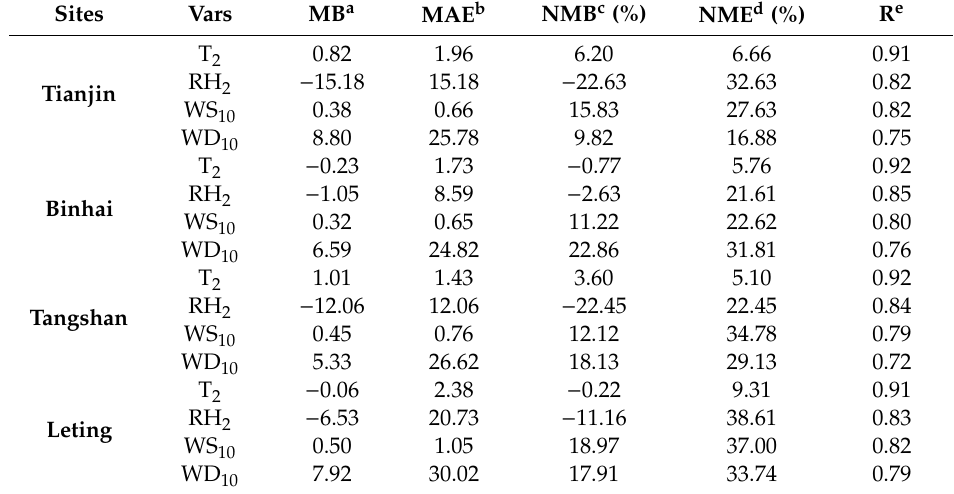
Table 3. Performance statistics for temperature at 2 m (T 2 ), relative humidity at 2 m (RH 2 ), wind speed at 10 m (WS 10 ), and wind direction at 10 m (WD 10 ) at four sites within the study area.